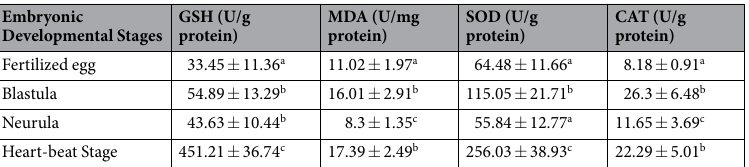
Table 4. The contents changes of antioxidants. Data are shown as mean ± SD (standard deviation) of each developmental stage in three separate individuals. Little letters indicate expression difference of antioxidants in different developmental